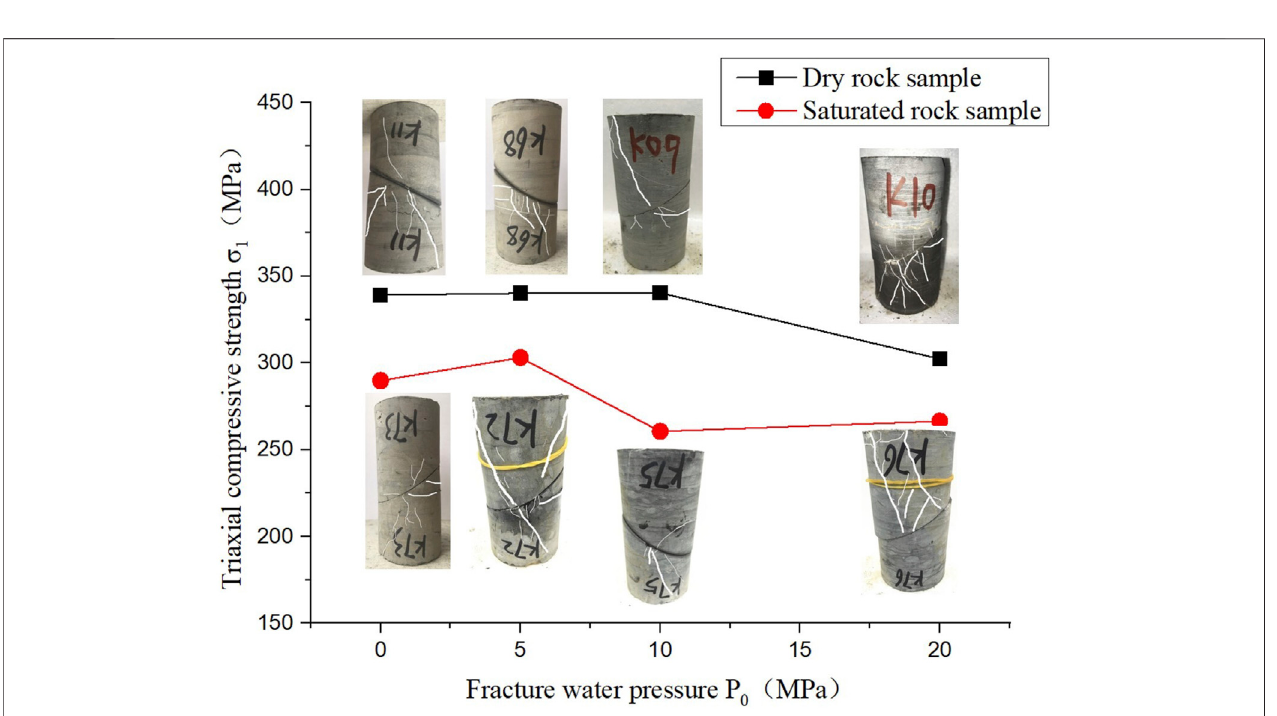
FIGURE3 | Strength and failure characteristics of dry and saturated samples(Thick white lines represent theprincipal cracks and the thin whitelines represent the secondary cracks).